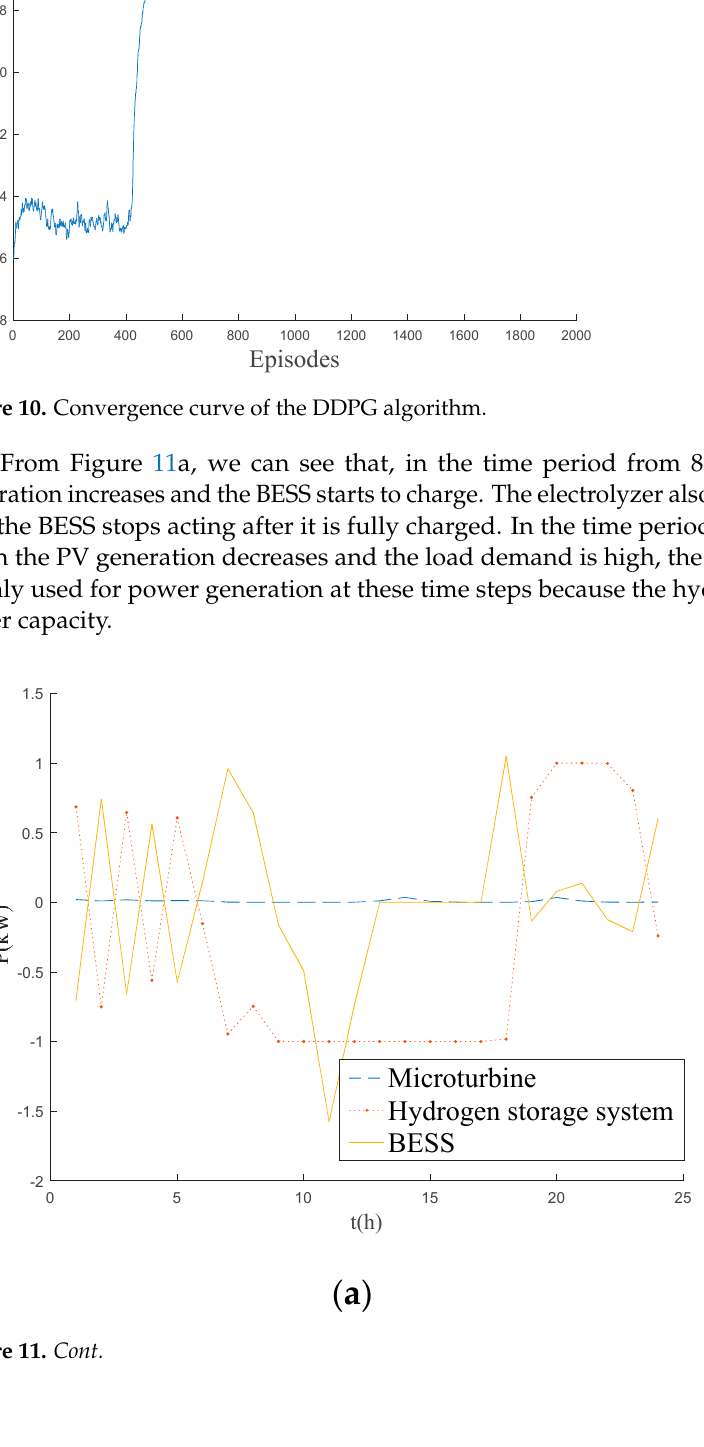
Figure 10. Convergence curve of the DDPG algorithm.